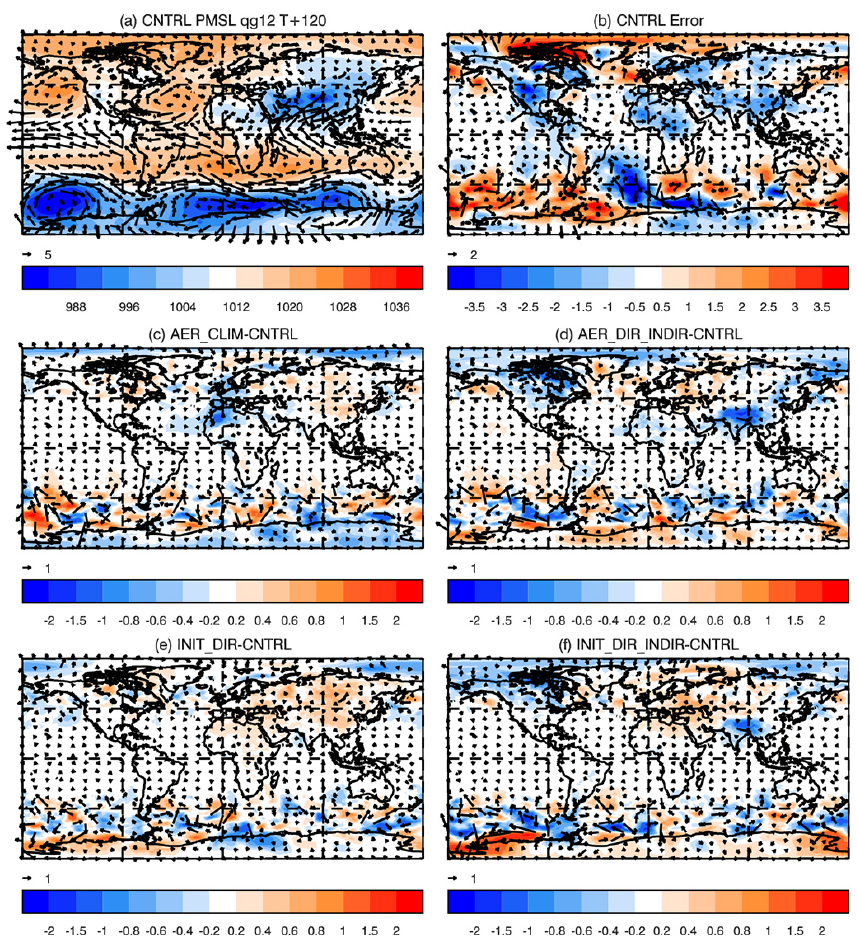
Fig. 17. Impact of different aerosol representations on MSLP and 925hPa winds at T + 120: (a) CNTRL, (b) CNTRL error, (c) AER_CLIM- CNTRL, (d) AER_DIR_INDIR-CNTRL, (e) INIT_DIR-CNRTL, (f)